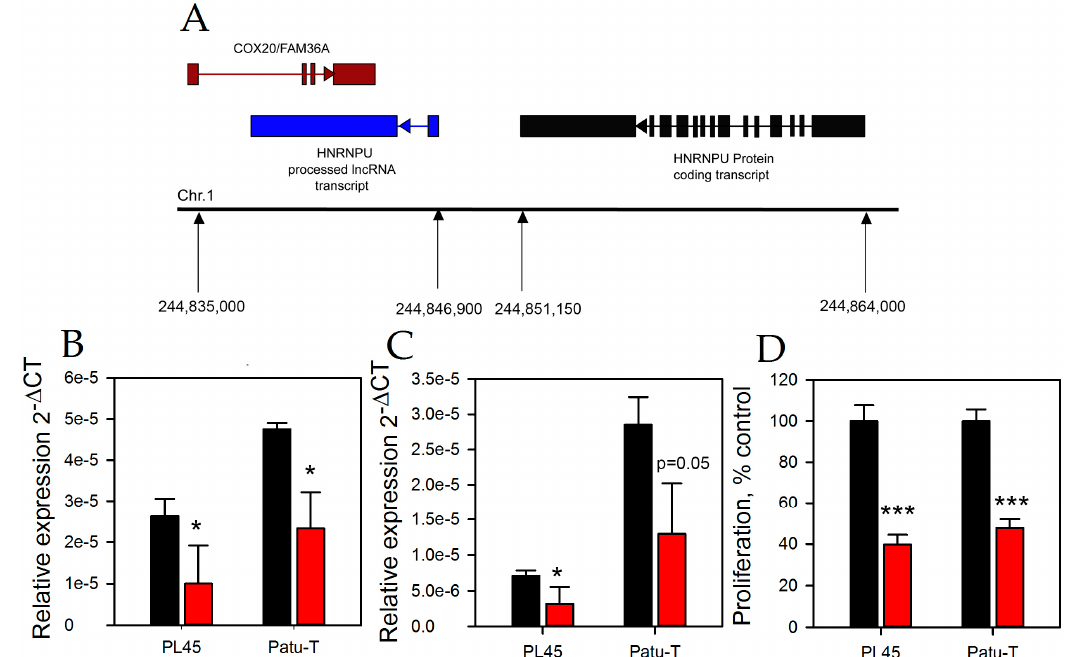
Figure 4. ( A ) Map of genomic location of the HNRNPU processed transcript lncRNA and HNRNPU and COX20/FAM36A protein coding genes. ( B ) Patu-T and PL45 cells were exposed to 50 nM of HNRNPU siRNA (red bars) or control oligo (black bars) for 48 h. The expression of HNRNPU protein coding gene relative to 18S rRNA was determined by qPCR. ( C ) Patu-T and PL45 cells were exposed to 50 nM of HNRNPU siRNA (red bars) or control oligo (black bars) for 96 h and the expression of HNRNPU processed transcript relative to 18S rRNA was deterined by qPCR. ( D ) Cell proliferation was measured using a WST1 assay in the cell lines treated with HNRNPU siRNA (red bars) or control oligo (black bars) for 96 h. * p < 0.05, *** p < 0.001.